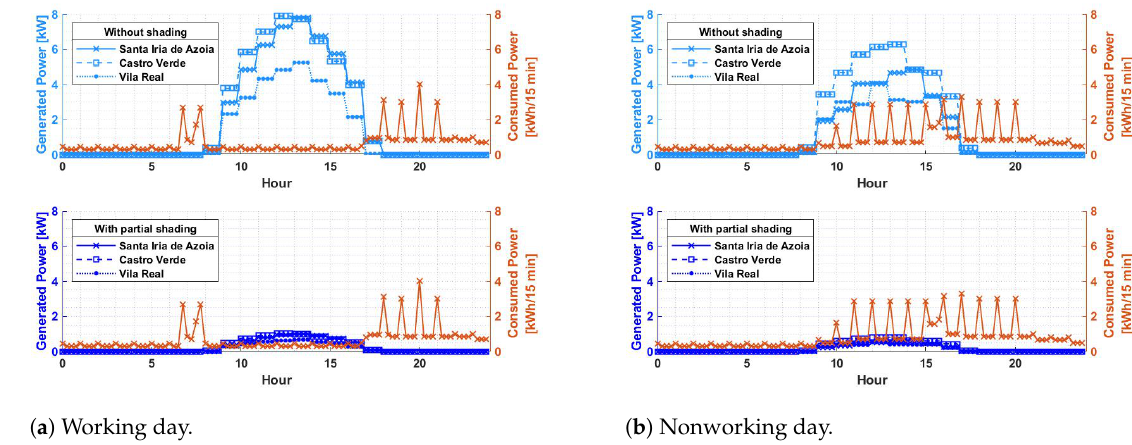
Figure 5. Generation and consumption curves on the two significant days of January for CIGS technology.